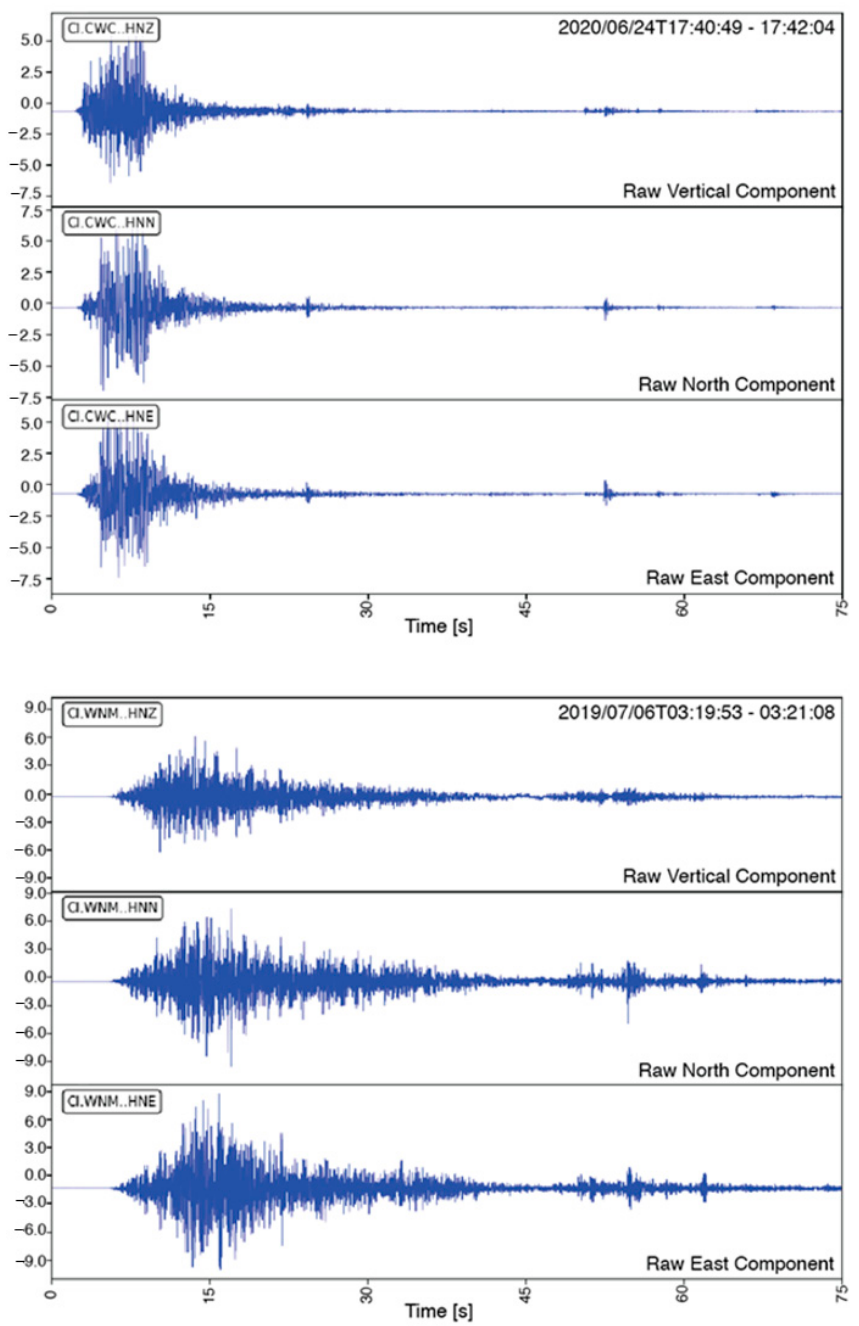
Figure 3. Seismograms for both events. Top : raw seismograms for the M W 5.8 Owens Lake earthquake recorded at station CWC: Southern California Seismic Network. Vertical, north, and east components as a function of time in seconds relative to 2020-06-24T17:40:48.9983. Bottom : raw seismograms for the M W 7.1 Ridgecrest event recorded at station WNM: Southern California Seismic Network. Vertical, north, and east components as a function of time in seconds relative to 2019-07-06T03:19:53. The source of the waveform data for both events is provided in Table